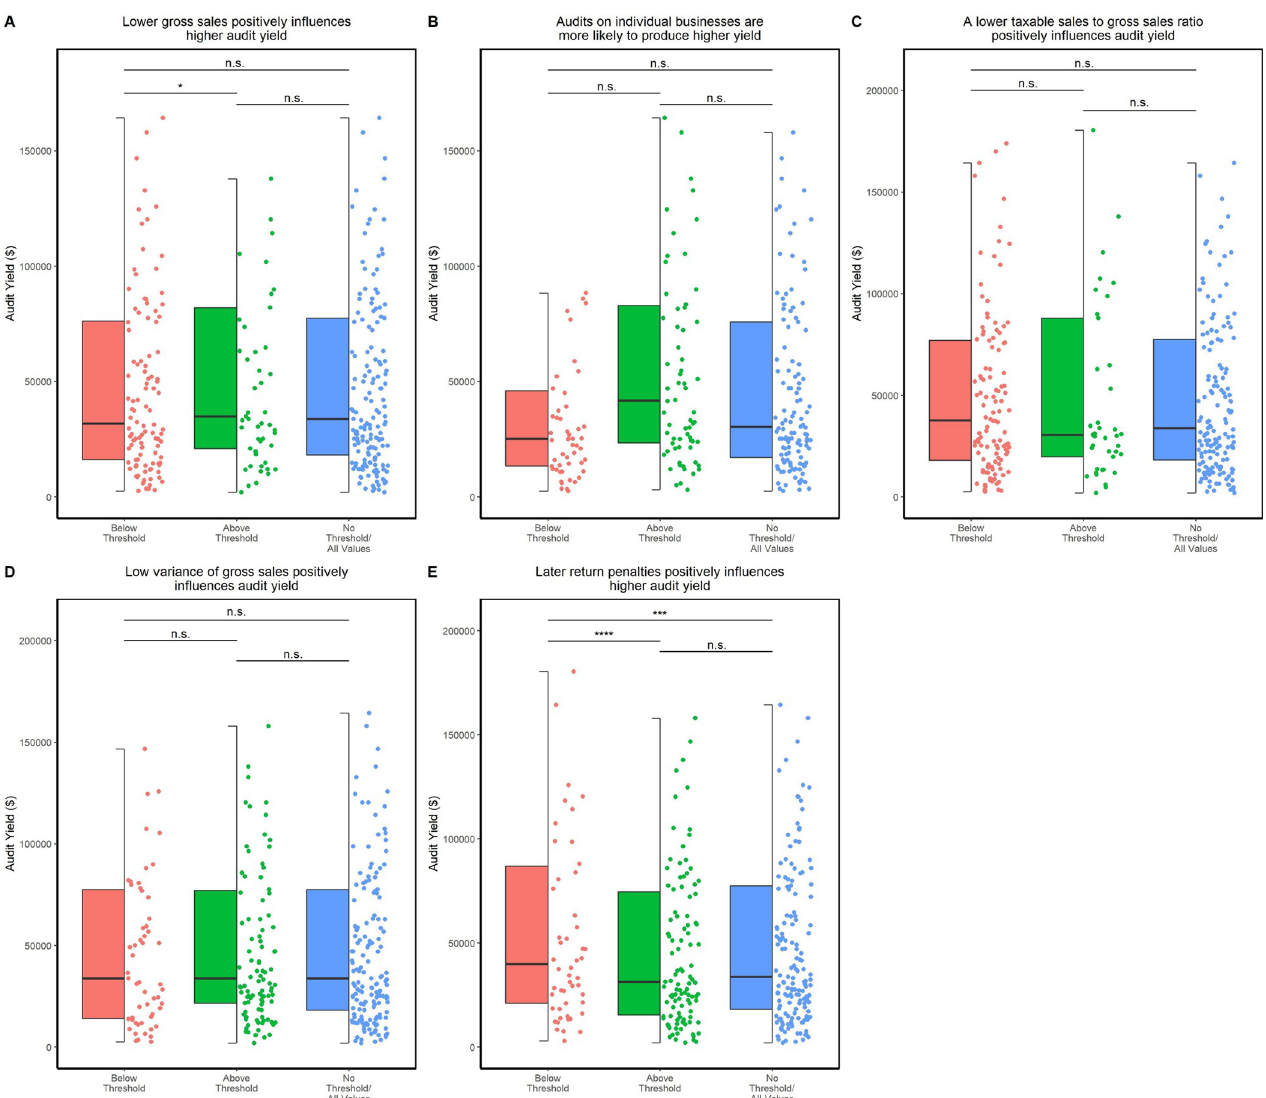
Fig 3. Statistical validation using Wilcoxon-ranksum test of all five hypotheses. Distribution of data for each threshold bin are plotted with statistical significance denoted above each pair of groups. � denotes a p-value less than 0.1, �� a p-value less than 0.05 and ��� a p-value less than 0.001. n.s. denotes a non- significant result. For all graphs above, the threshold was set to the